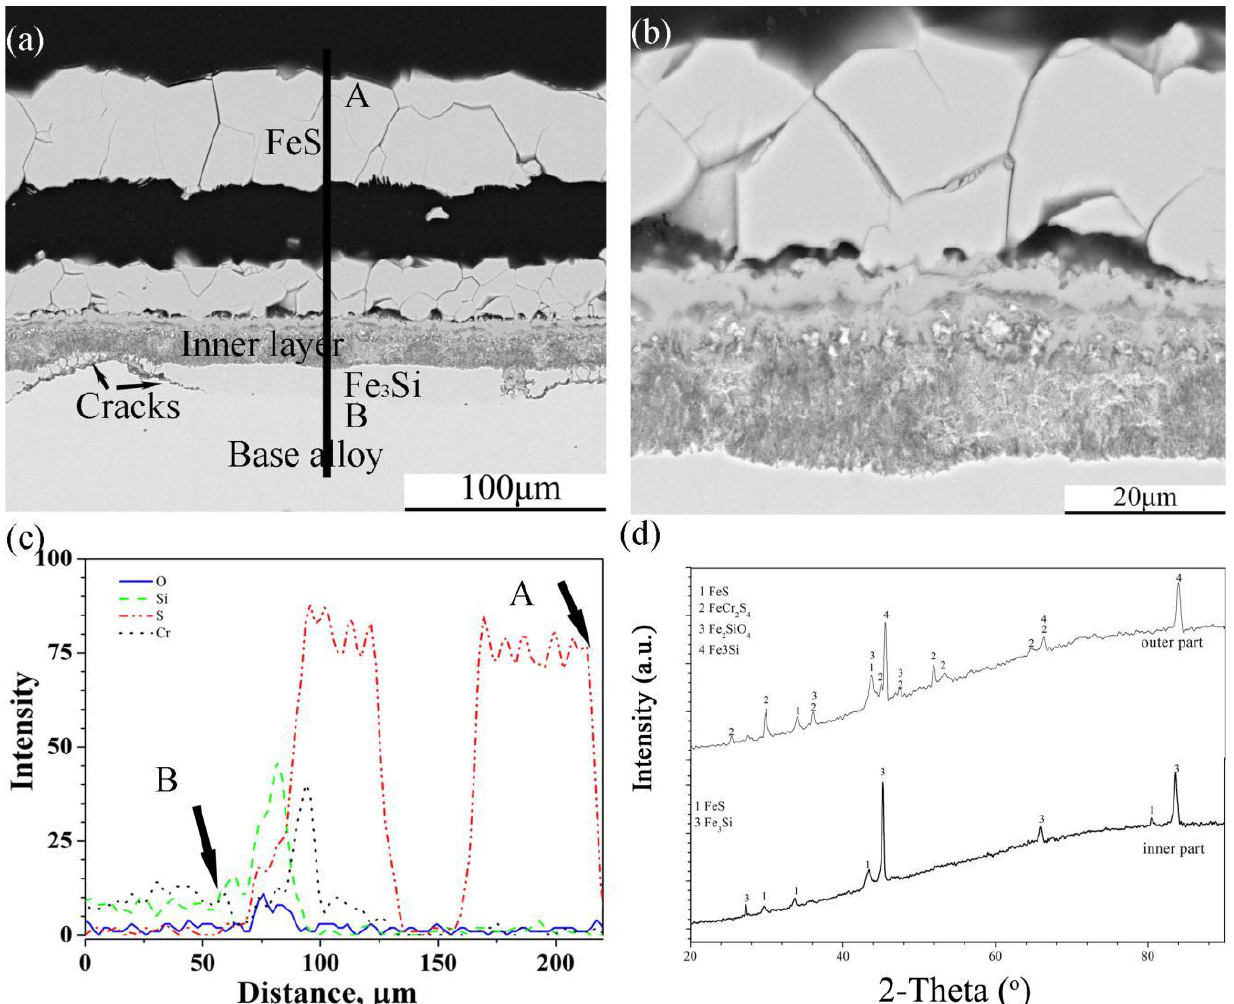
Figure 8. Cross-sectional image: ( a ) low-magnification, ( b ) high-magnification, ( c ) element depth profile analysed by EDS, where the scanning line AB corresponds to the line AB in ( a ) and XRD spectrum ( d ) of Fe-5Cr-10Si alloy corroded in H 2 -CO 2 -H 2 S mixture at 600 °C for 24 h. The corrosion of Fe-10Cr-10Si produced an external layer of sulphides and a thin internal layer rich in oxides followed by a discontinuous intermetallic compound layer of Fe 3 Si (Figure 9a). Furthermore, the external layer was divided into two sub-layers (Figure 9b). According to the XRD pattern of the external layer, the corrosion products of the external layer were FeS and FeCr 2 S 4 (Figure 9c). The chemical composition (at.%) of the different parts of the scales analysed by EDS are shown in Table 3.